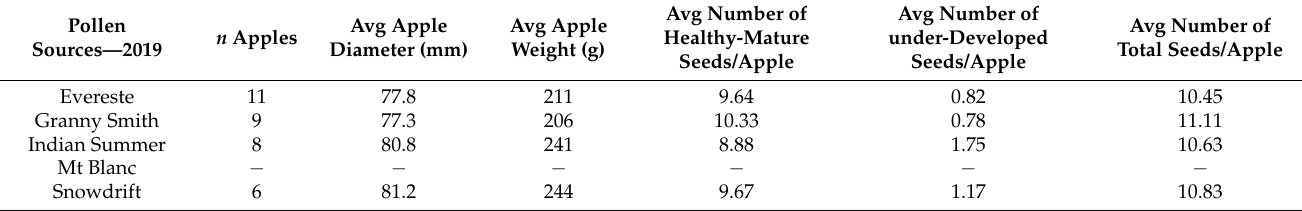
Table 2. ‘WA 38’ apple size (mm), weight (g), and seeds analysis (healthy-mature, underdeveloped, and total seeds) in 2019 and 2020: Comparison between four pollen sources in 2019 and five pollen sources in 2020. Significance (across pollens) of the model is reported in the legend: NS = not significant (proc GLM in SAS